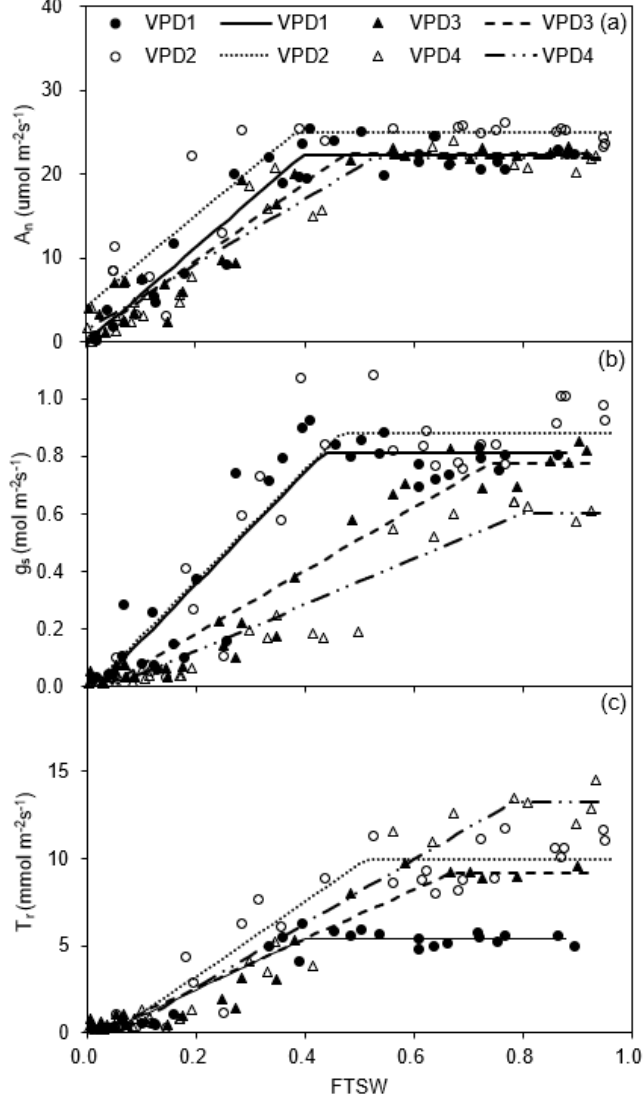
Figure 1. Changes in net photosynthetic rate ( A n ; ( a )), stomatal conductance ( g s ; ( b )) and transpiration rate ( T r ; ( c )) of potato plants grown under different vapor pressure deficits (VPD) in the greenhouse cells during progressive soil drying. VPD1, normal temperature and high relative humidity; VPD2, high temperature and relative humidity; VPD3, normal temperature and low relative humidity; VPD4, high temperature and low relative humidity, the same as